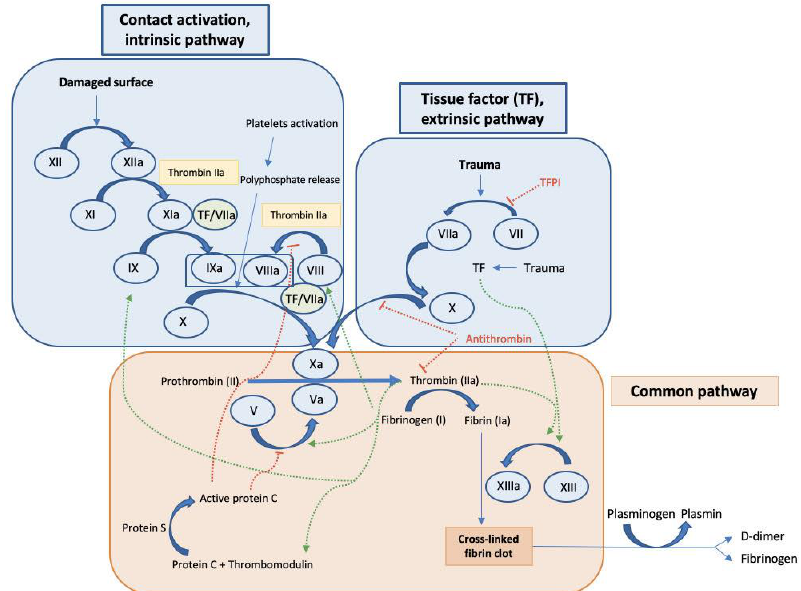
Figure 1. General coagulation cascade. Intrinsic pathway, extrinsic pathway, and common pathway. The cascade is initiated by surface contact or tissue damage leading to the activation of factor XII in the intrinsic pathway or factor VII in the extrinsic pathway, which both continues with the activation of the coagulation cascade leading to the activation of factor X and initiating the mechanisms included in the common pathway resulting in fibrin activation and finally clot formation. In addition, activating signals (green arrows), and inhibitory mechanisms (red dotted lines) are observed.